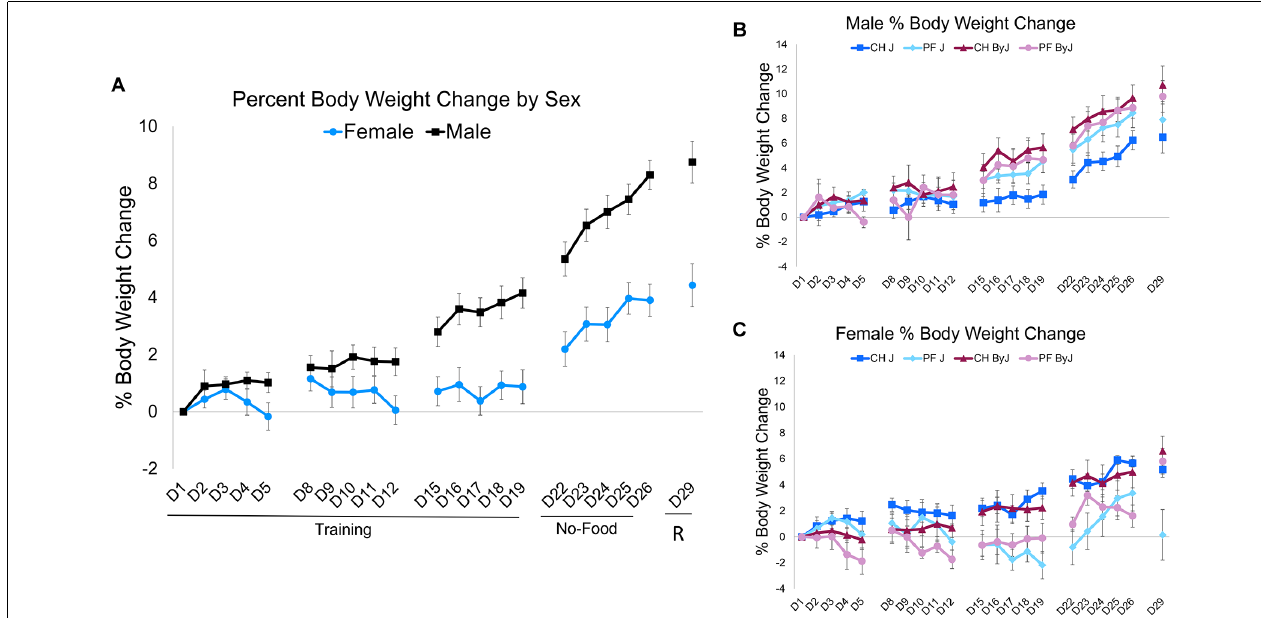
FIGURE 3 | Changes in body weight during food intake trials (D1-D19) and during no-food training/re-exposure trials (D22-D29). (A) Body weight across training trials, no-food training, and re-exposure of food intake. Percent change in body weight from day 1. For the Training period, repeated measures (Day) ANOVA (Diet, Substrain, Sex) indicated no main effect of Day ( F (13,763) = 1.52, p = 0.10). However, there was an interaction between Day and Substrain ( F (13,763) = 2.15, p = 0.010) and an interaction between Day and Sex ( F (13,763) = 2.88, p = 0.00045). In considering percent body weight change during the no-food training and re-exposure period, repeated measures (Day) ANOVA (Diet, Substrain, Sex) indicated no main effect of Day ( F (5,324) = 0.37, p = 0.87) nor were there any significant interactions ( p s > 0.44). (B) Male body weight across training trials. (C) Female body weight across training trials. Ns = 16 J female (8 PF, 8 CH), 15 J male (7 PF, 8 CH), 16 ByJ female (8 PF, 8 CH), 16 ByJ Male (8 PF, 8